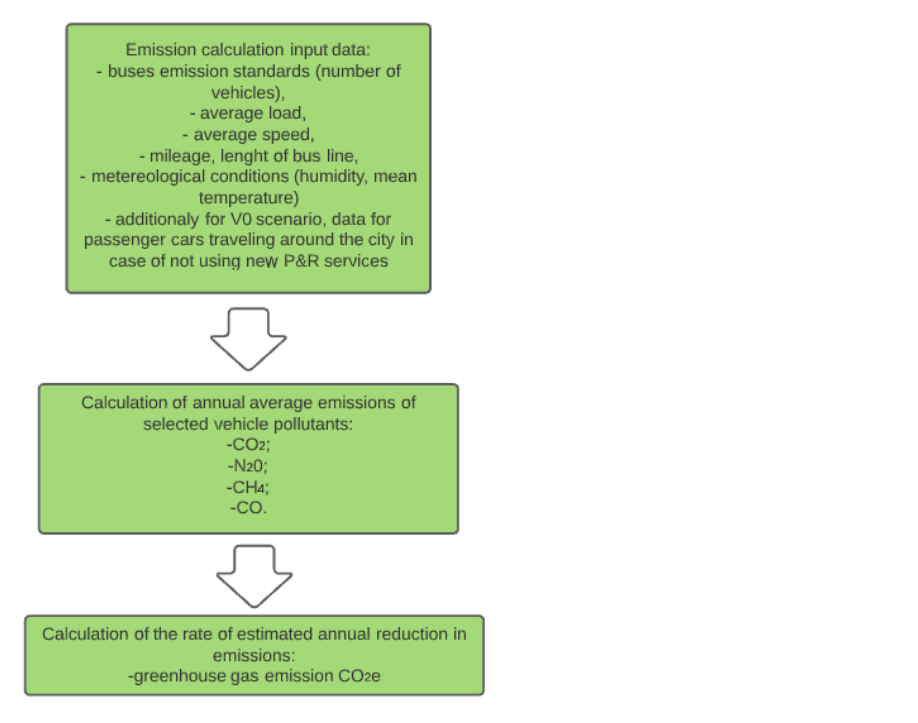
2 e emission calculation methodology for